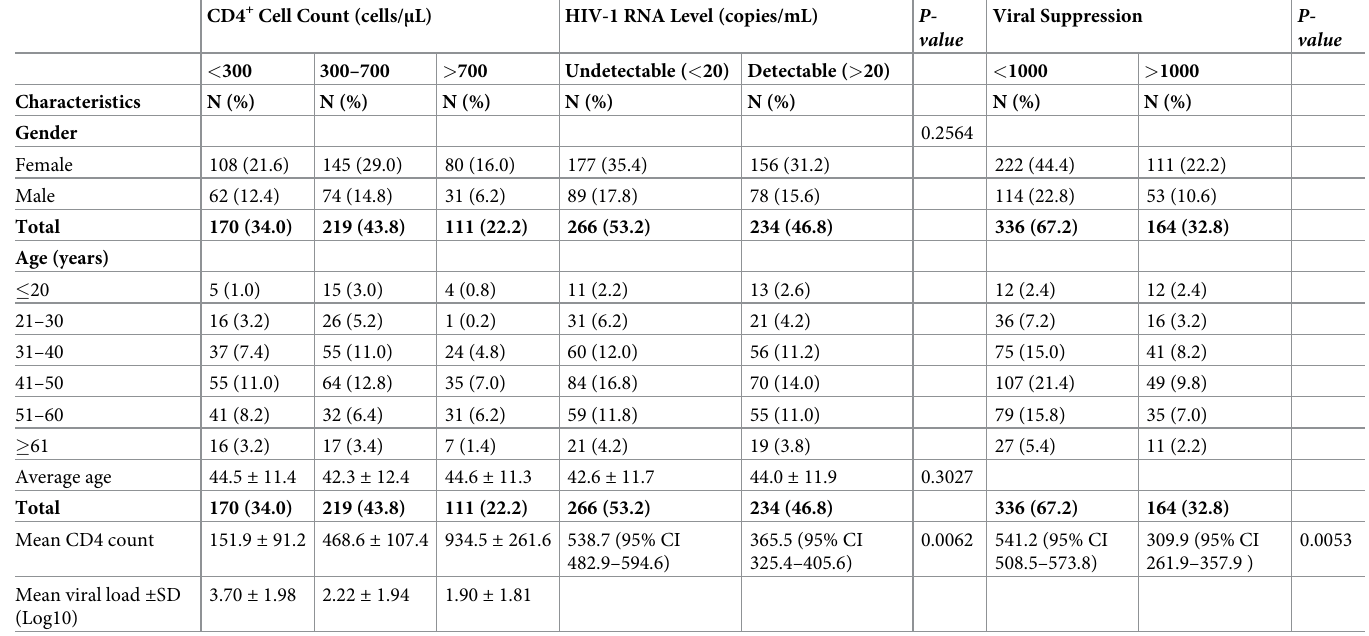
Table 2. Correlation between CD4 count and HIV-1 RNA